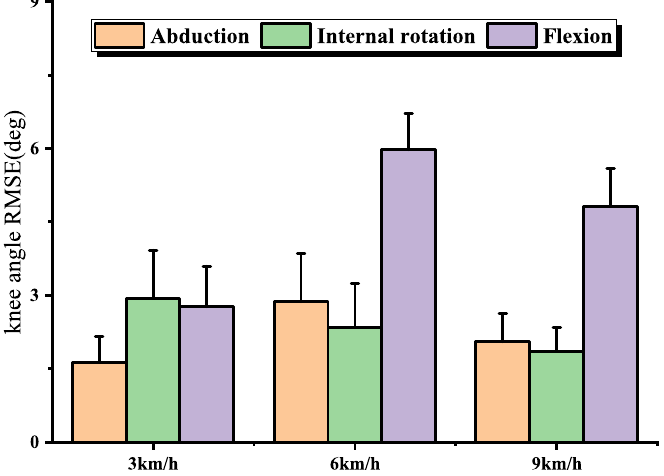
Figure 9. Comparison of IMU-based and optical motion capture system data-based 3-DOF knee angle estimations of RMSEs during different motions, the bar and error bar represent the mean and SD of the